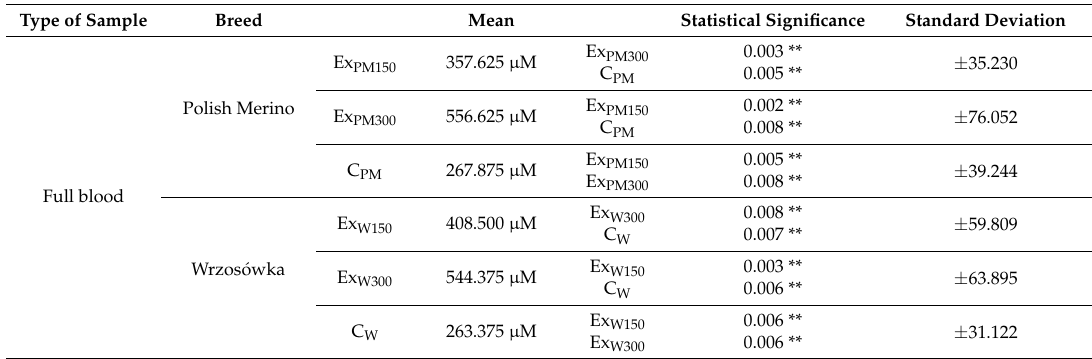
Table 4. Capacity of reduced glutathione ( µ M) in full blood collected from both breeds as affected by the dose of the additive.